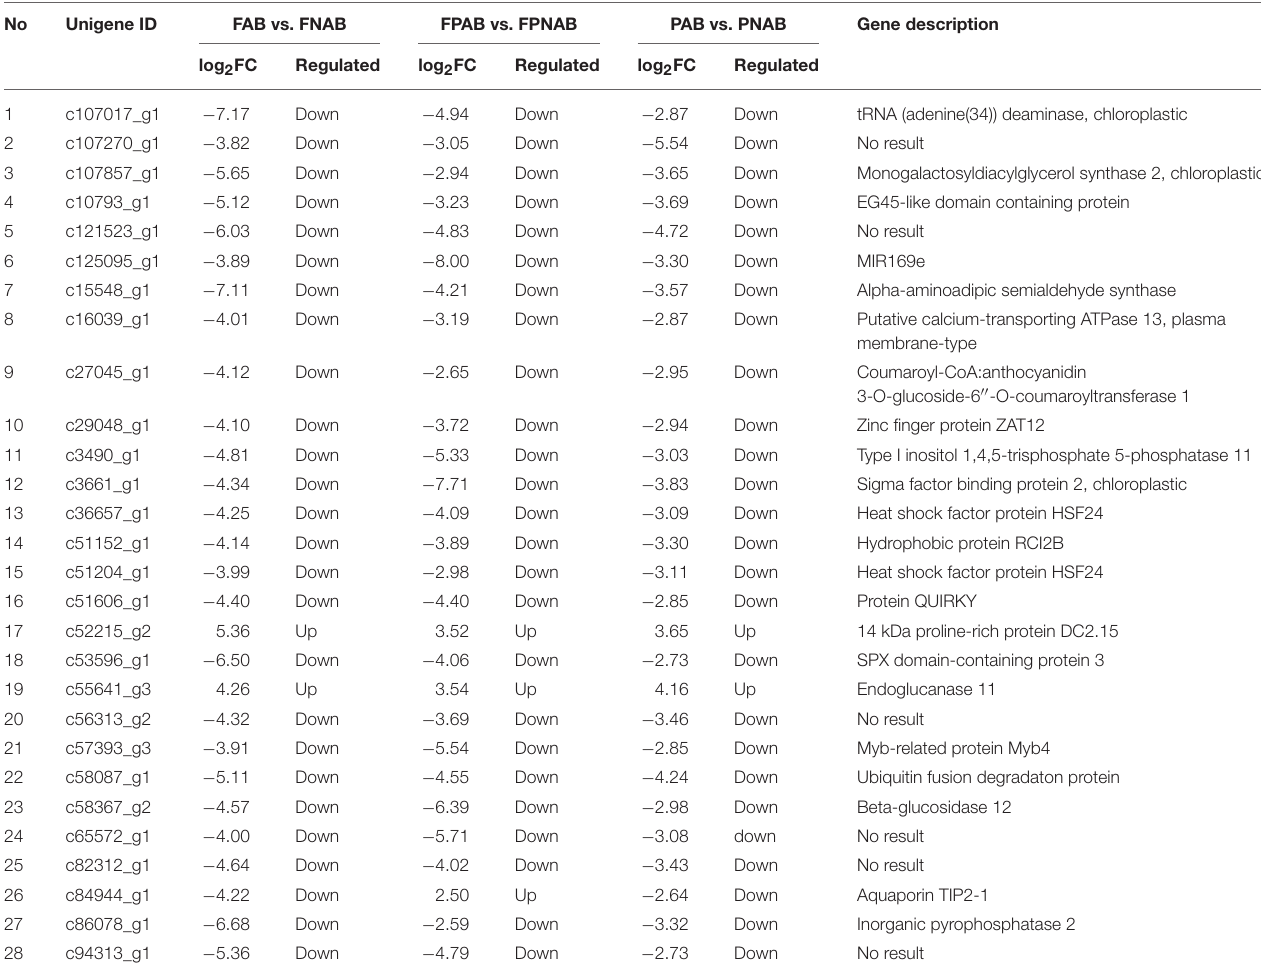
TABLE 6 | List and annotation of common DEGs identified in all three comparison of libraries FAB vs. FNAB, FPAB vs. FPNAB, PAB vs. PNAB. No Unigene